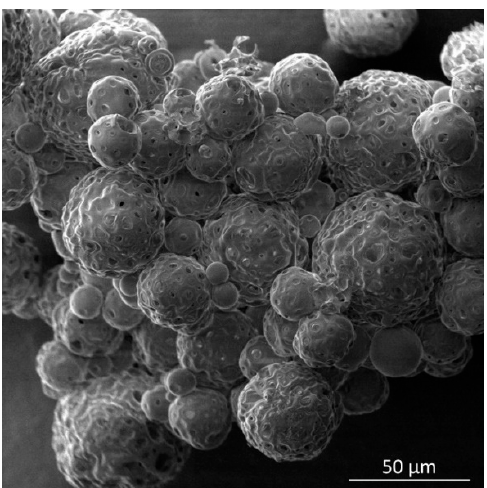
Figure 1. SEM micrograph of colophony microcapsules added to modify the acrylic coating.